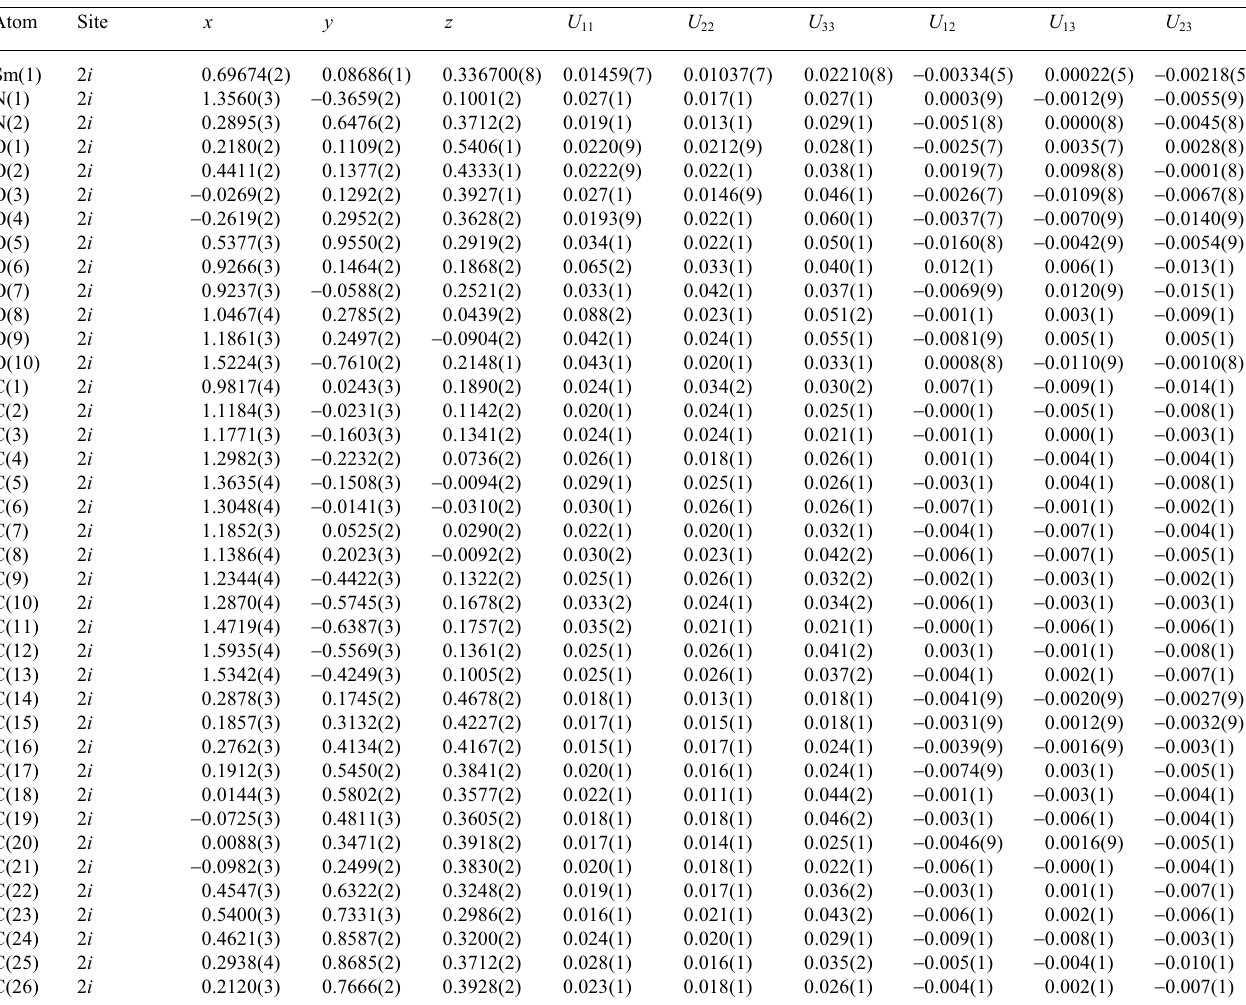
Table 3. Atomic coordinates and displacement parameters (in Å 2 )